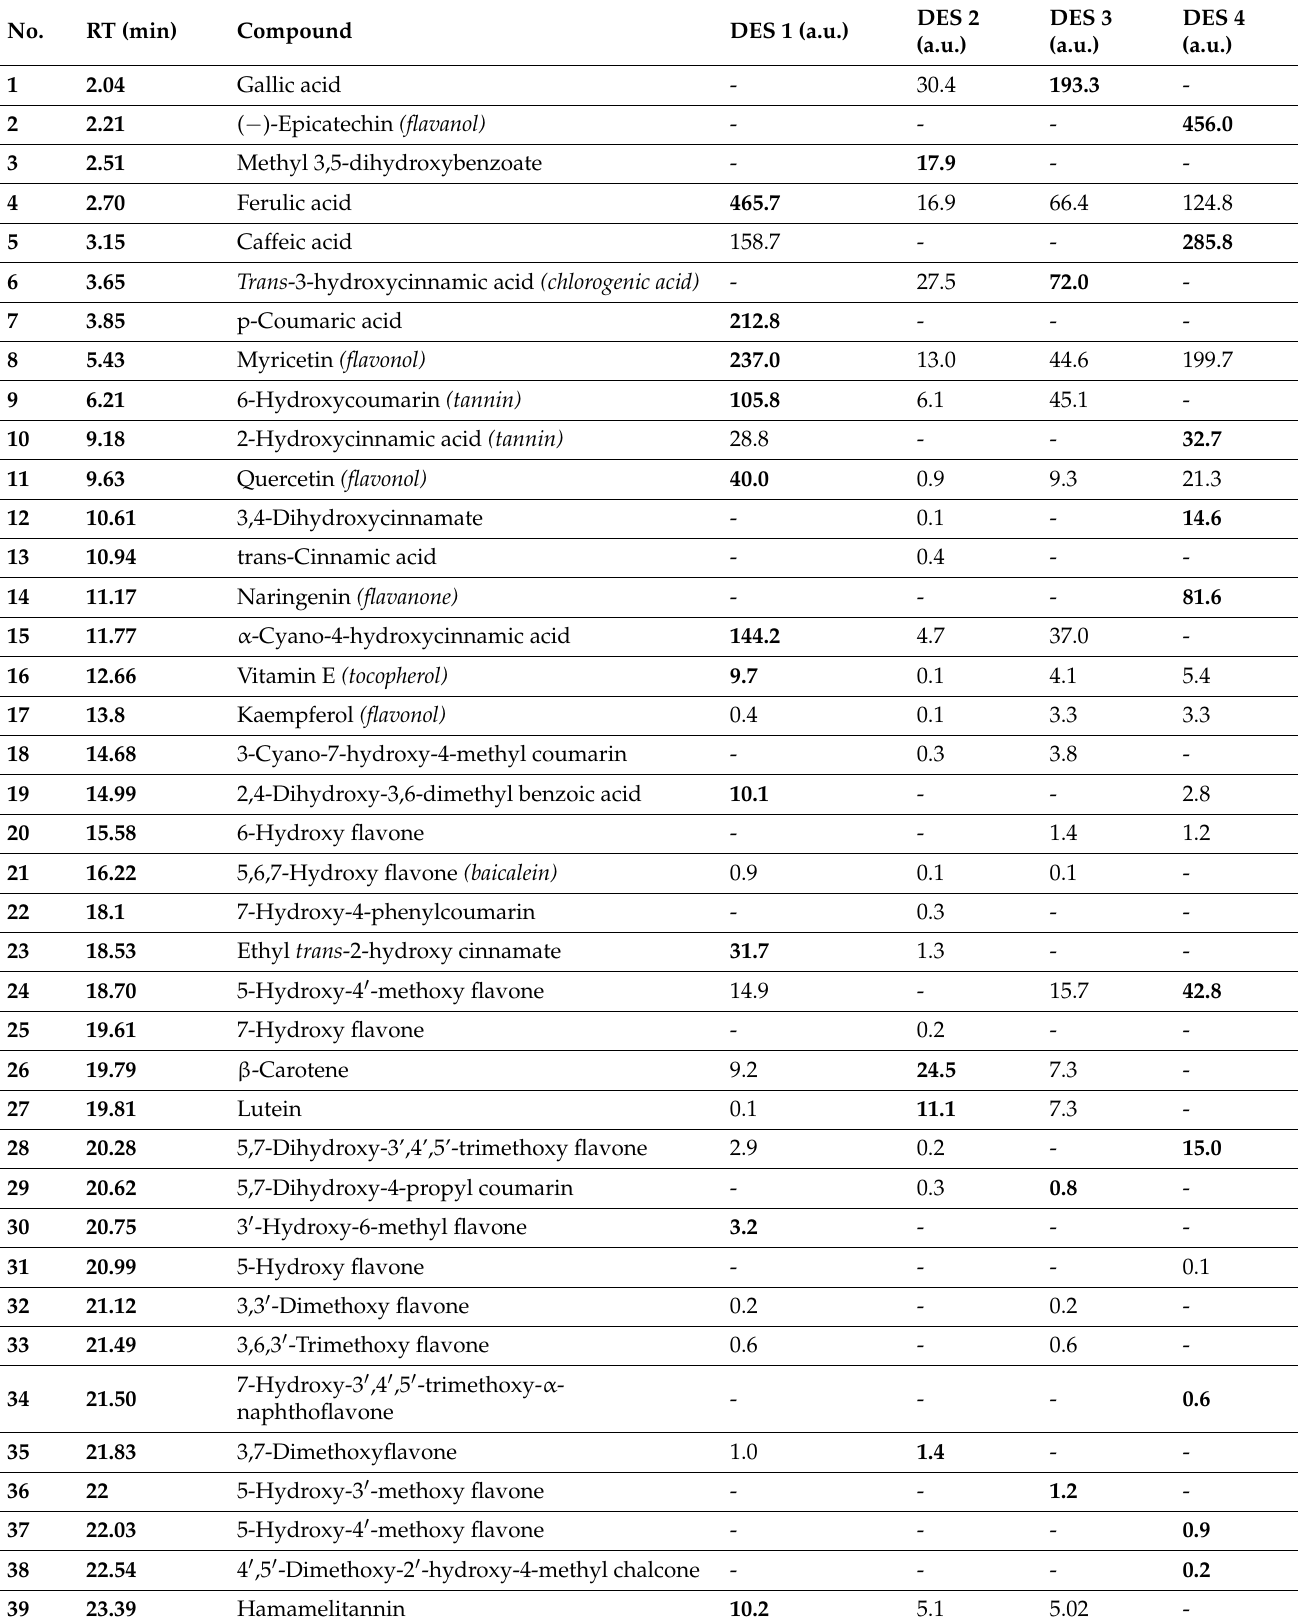
Table 8. Identification of molecules in tomato pomace extracts by HPLC–DAD (a.u.: area